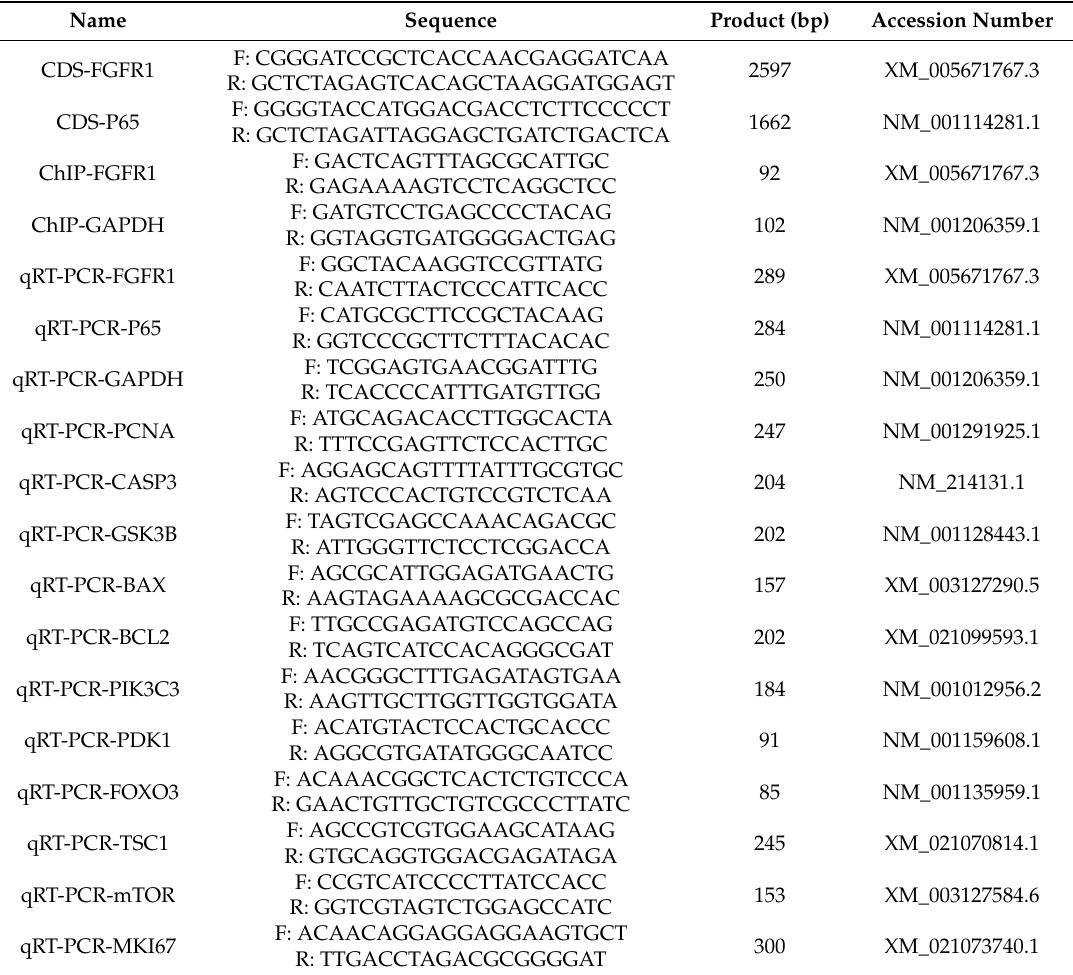
Table 1. Primers of real-time PCR (RT-PCR), chromatin immunoprecipitation (ChIP) assay, and coding sequence